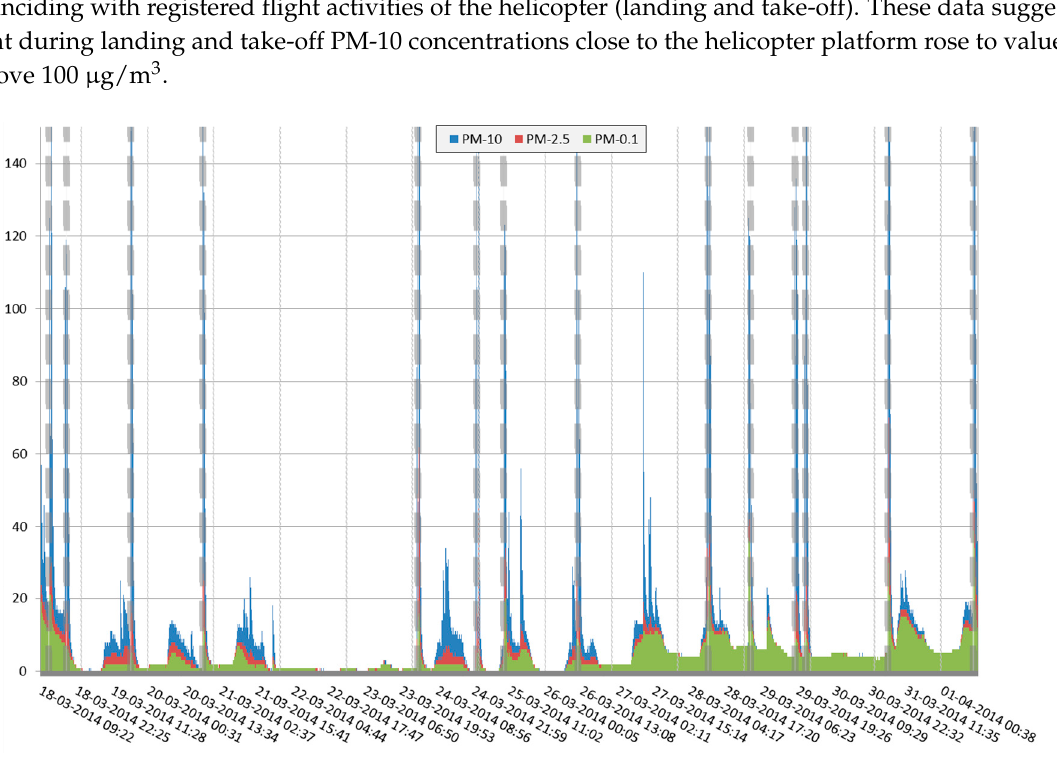
Figure 3. Time resolved pattern of indoor concentrations of PM in µ g/m 3 at the rooftop service building next to the helicopter platform. Helicopter landing and take-off events are indicated by vertical dotted lines and labelled with date (dd-mm-yyyy) and approximate (uu:mm) time of these events. In Table 3 the parameters characterizing outdoor air quality at three outdoor locations are presented. Concentrations of gas phase air pollutants were relatively low on both reference locations and the helicopter platform. For nitrogen dioxide (NO 2 ) the two-week average ranged from 15.5 to 17.4 µ g/m 3 . Indoor and outdoor formaldehyde was detected on all indoor and outdoor locations and represents a normal background in Europe [16]. The outdoor TVOC values at the helicopter platform showed comparatively higher values compared to the other two outdoor reference locations.